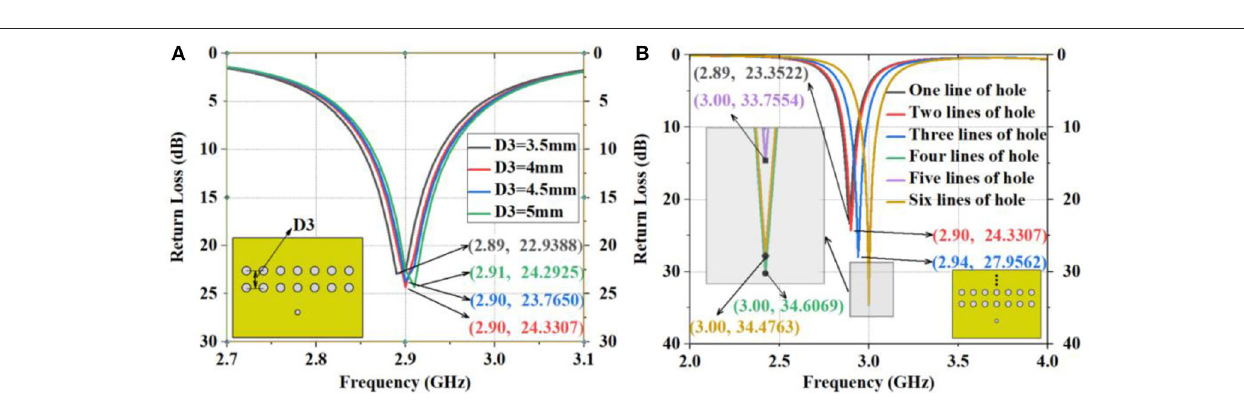
FIGURE 5 | The simulation of D3 and different lines of drilled holes. (A) Different dimensions of D3, (B) Return loss of antenna with 1, 2, 3, 4, 5, and 6 lines of holes.